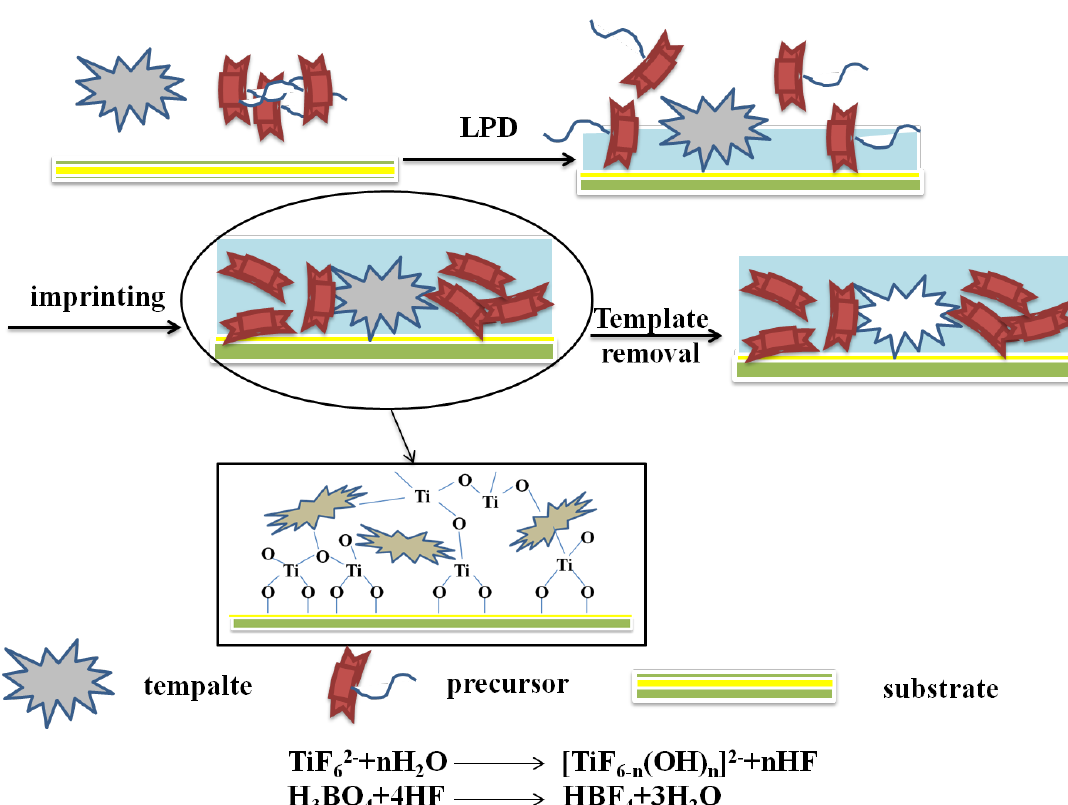
Figure 5. Scheme and process for preparation of MIPs modified TiO 2 nanomaterials by the LPD method.